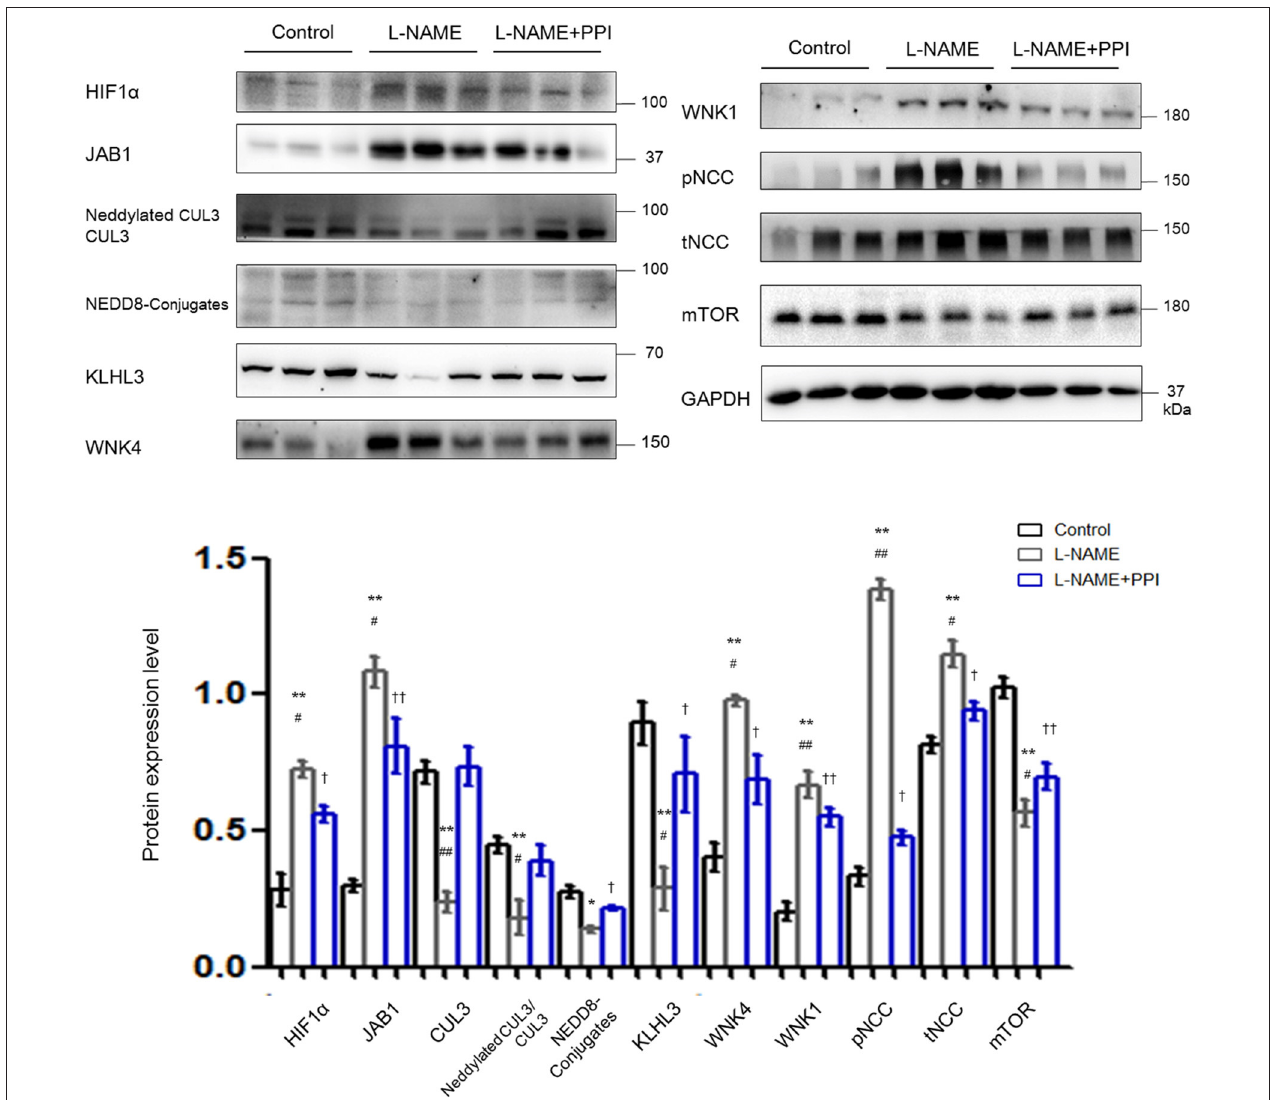
FIGURE 3 | Downregulation of CRL3 function was involved in the accumulation of WNK kinases in the kidney of pregnant L -NAME–treated mice. Protein levels were detected by Western blotting, including (1) hypoxia-inducible factor 1 α (HIF1 α ), member of the COP9 signalosome JAB1, CUL3 abundance and neddylation, NEDD8 conjugates and adaptor KLHL3; (2) substrates of CRL3 including WNK4 and WNK1 and phosphorylated NCC (pNCC) and total NCC (tNCC); and (3) autophagy marker mTOR. Expressions of these proteins in the kidney were statistically all significant after normalization to GAPDH among control, L -NAME, and L -NAME + PPI group (ANOVA with Tukey post hoc analysis). Data are presented as the mean ± SEM. * p < 0.05 and ** p < 0.01 compared between control and L -NAME group. # p < 0.05 and ## p < 0.01 compared between L -NAME and L -NAME + PPI group. † p < 0.05 and †† p < 0.01 compared between control and L -NAME + PPI